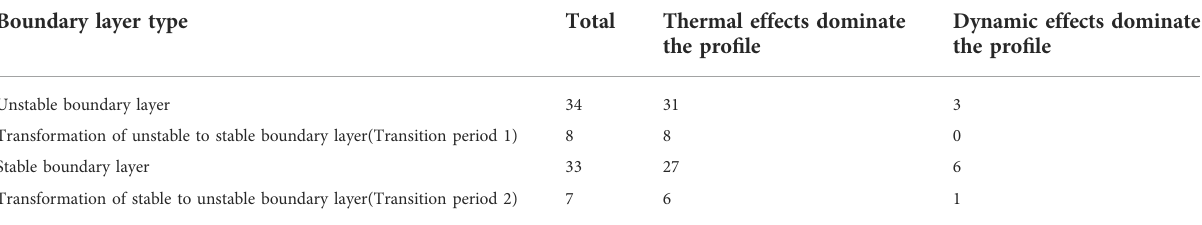
TABLE 2 Pro fi le statistics under different boundary layer